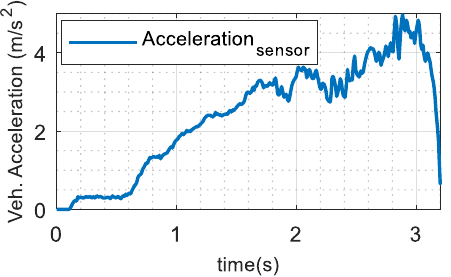
Figure 9. Longitudinal acceleration controller input variable.